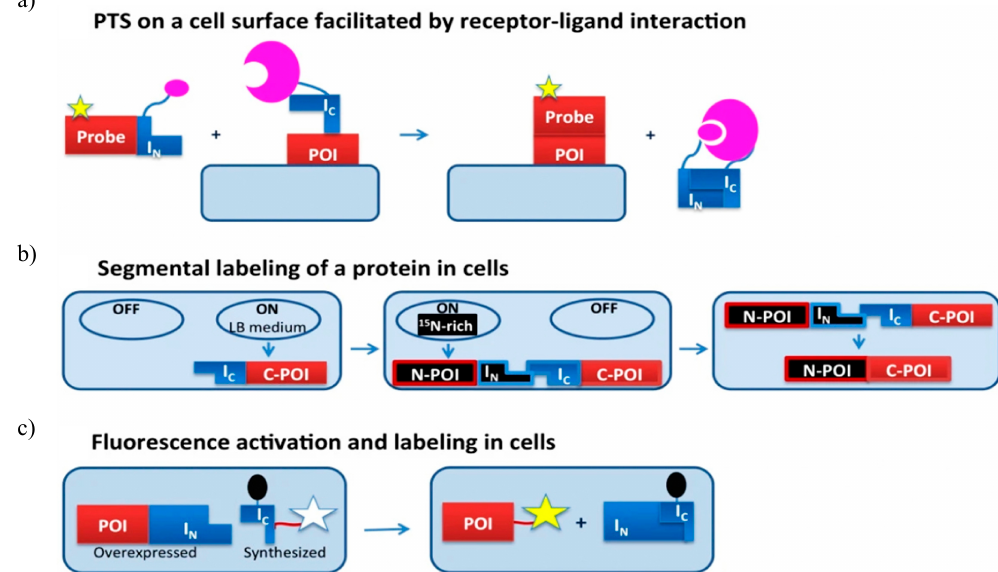
Figure 9. Schematic representations of intein-mediated protein labelling. POI is protein of interest. In ( a ), the complementary pink shapes represent the ligand and its receptor. In ( b ) ”off” and ”on” indicate conditional expression states from a plasmid, with the proteins in black 15 N labelled and those in blue or red are not labelled. In ( c ), the conversion of the star from clear to yellow indicates induction of fluorescence [9].